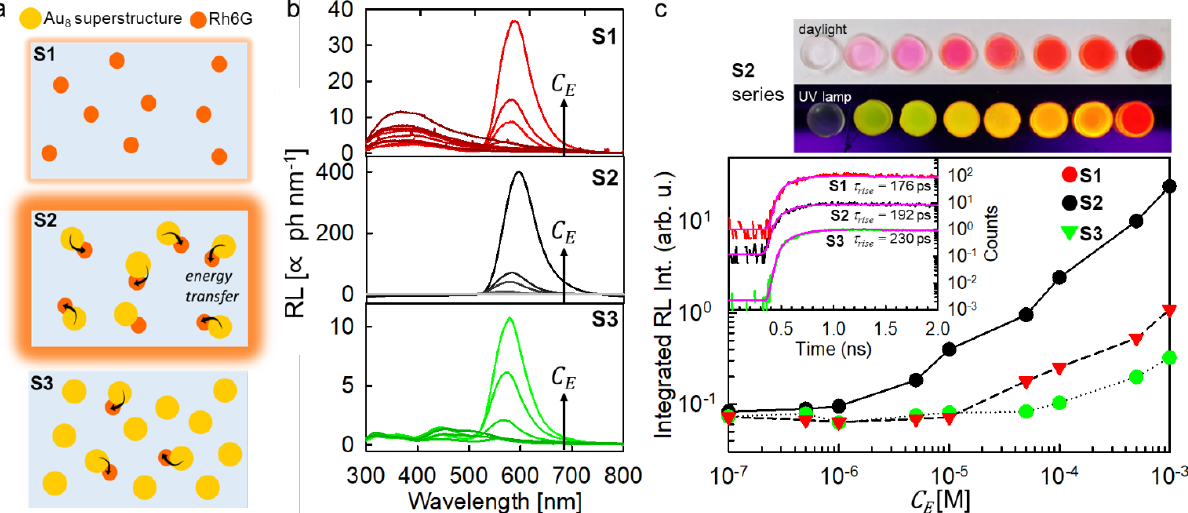
Figure 3. ( a ) Sketch of the composition of the three series (S1, S2, S3) of composites analyzed in this work. Dashed arrows indicate the occurrence of non-radiative energy transfer between in the Au 8 -Rh6G complexes. ( b ) RL spectra of the composite series as function of the emitter Rh6G concentration C E under soft X-rays exposure. ( c ) Digital picture of the most performing S2 series under daylight (top) and UV excitation and integrated RL intensity for the series of composites investigated (bottom). The inset of the bottom panel shows the rise of scintillation pulse of the sample with the highest loading level for each series recorded at 630 nm. The uncertainty of the rise times values is assessed at 50 ps.